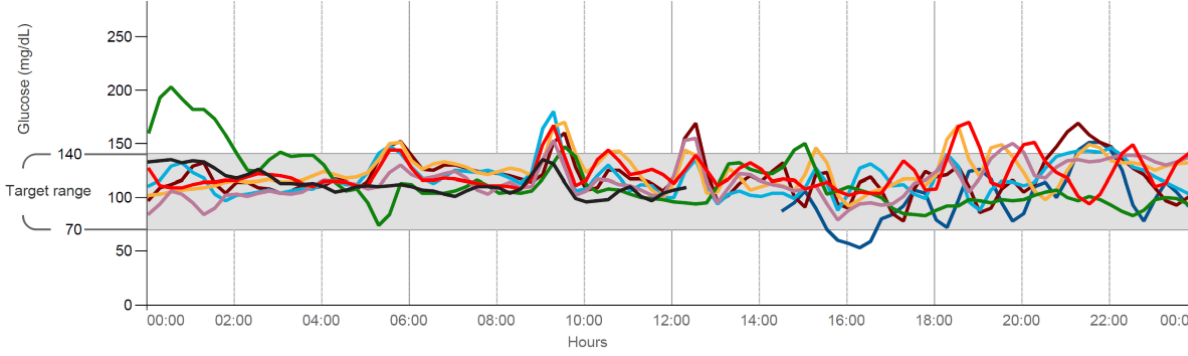
Figure 2. Example of continuous glucose monitor data downloaded from Abbott software and reviewed with participants during low-carbohydrate diet coaching with the study coordinator. Each individual colored line represents the collected glucose data for a distinct 24-hour